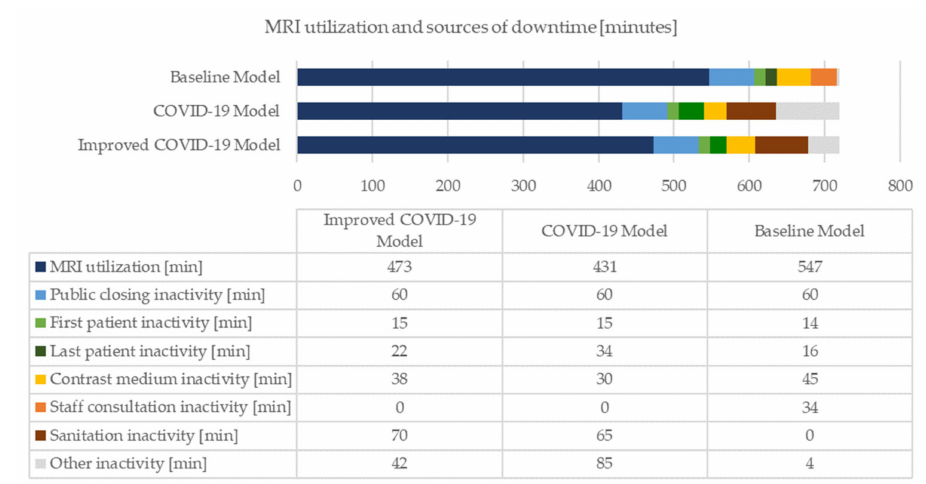
Figure 7. MRI utilization and sources of downtime.